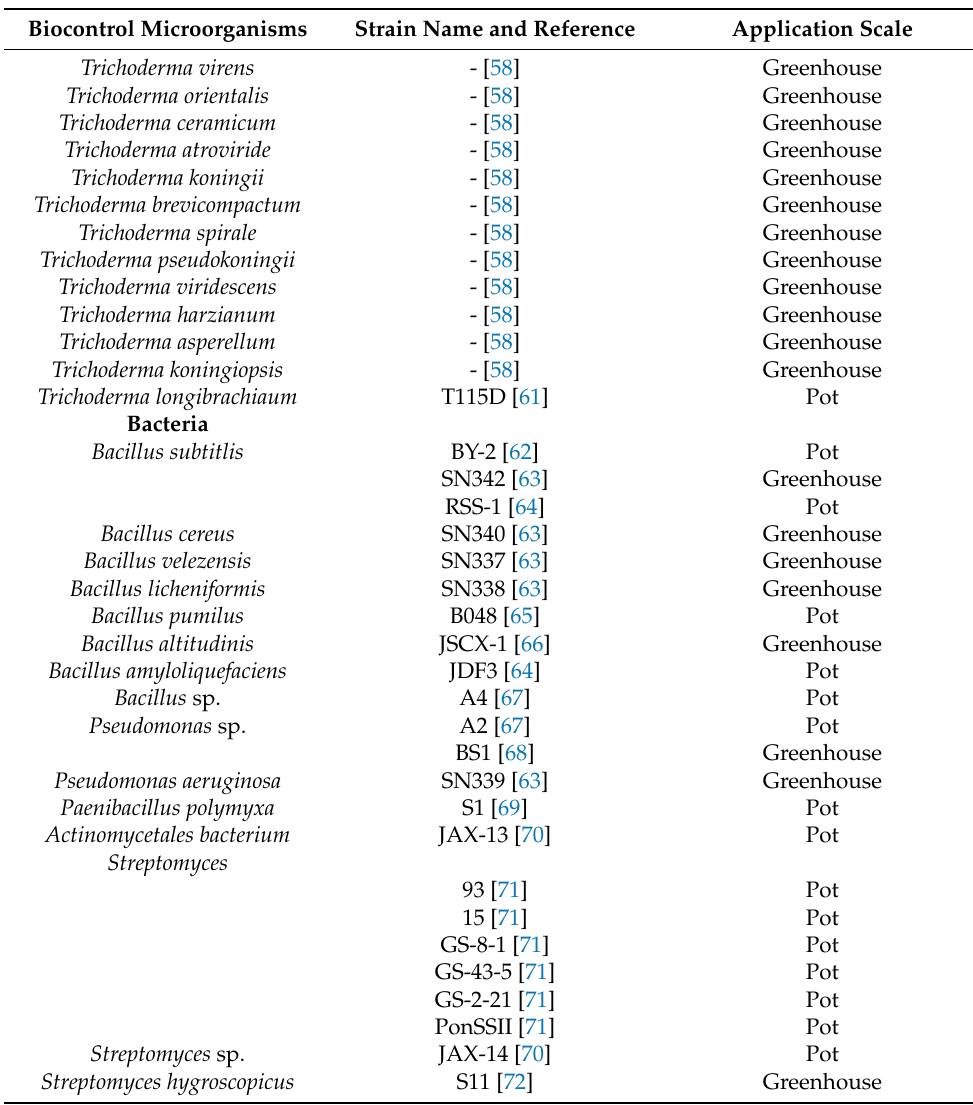
Table 2. Cont. Biocontrol Microorganisms Strain Name and Reference Application Scale